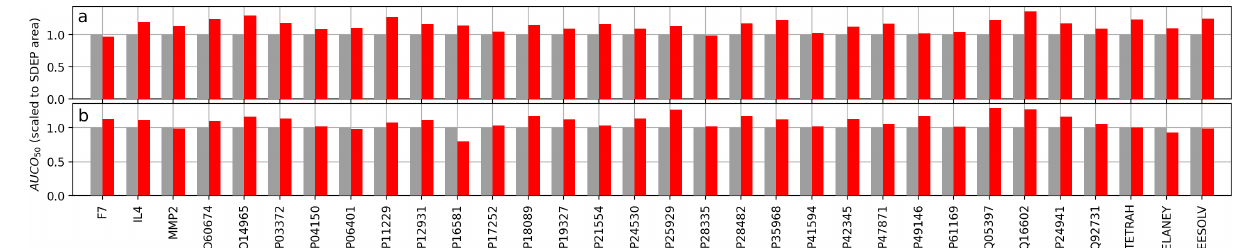
Figure 1. Comparison of the two UMs by AUCO 50 . All values were divided by the AUCO 50 of the SDEP to show relative areas. The height of each bar indicates the area between ideal curve and that of the measure (smaller is better). Bars corresponding to the SDEP are shown in gray, while bars of HVLs are colored red. The results are shown for all datasets ( a ) when using RDKit descriptors and ( b ) when using ECFPs. Table 1. Train performances and test performances for every dataset in combination with both descriptors. All calculations were performed at full floating-point precision, and the table was rounded afterwards. For the descriptor that achieved the better test performance on a particular dataset, Test MSE and Test R 2 are underlined and in bold. The median of each column is presented in the last